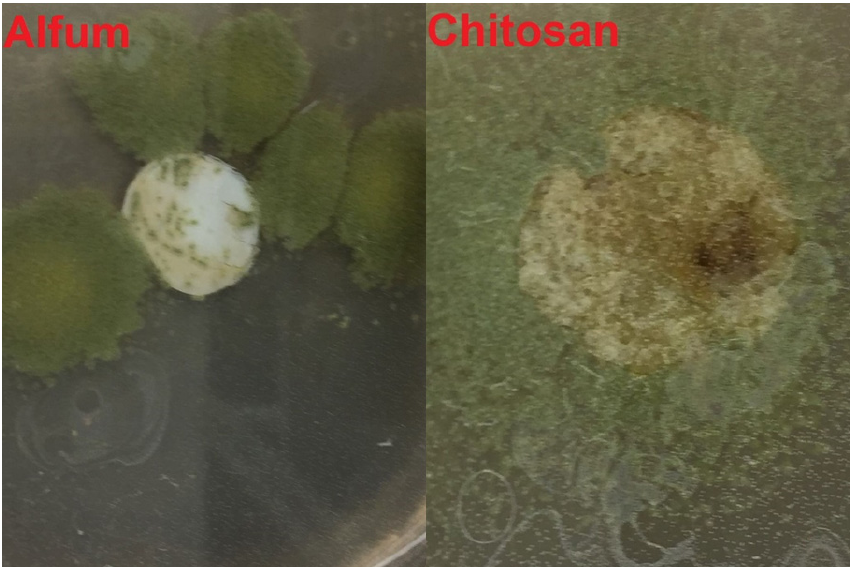
Figure 11. Representative pictures of Alfum and crosslinked chitosan materials in the fungus test with Aspergillus falconensis . (Visual naked-eye observation). The diameter of the pressed white composite pellet is 1.3 cm.